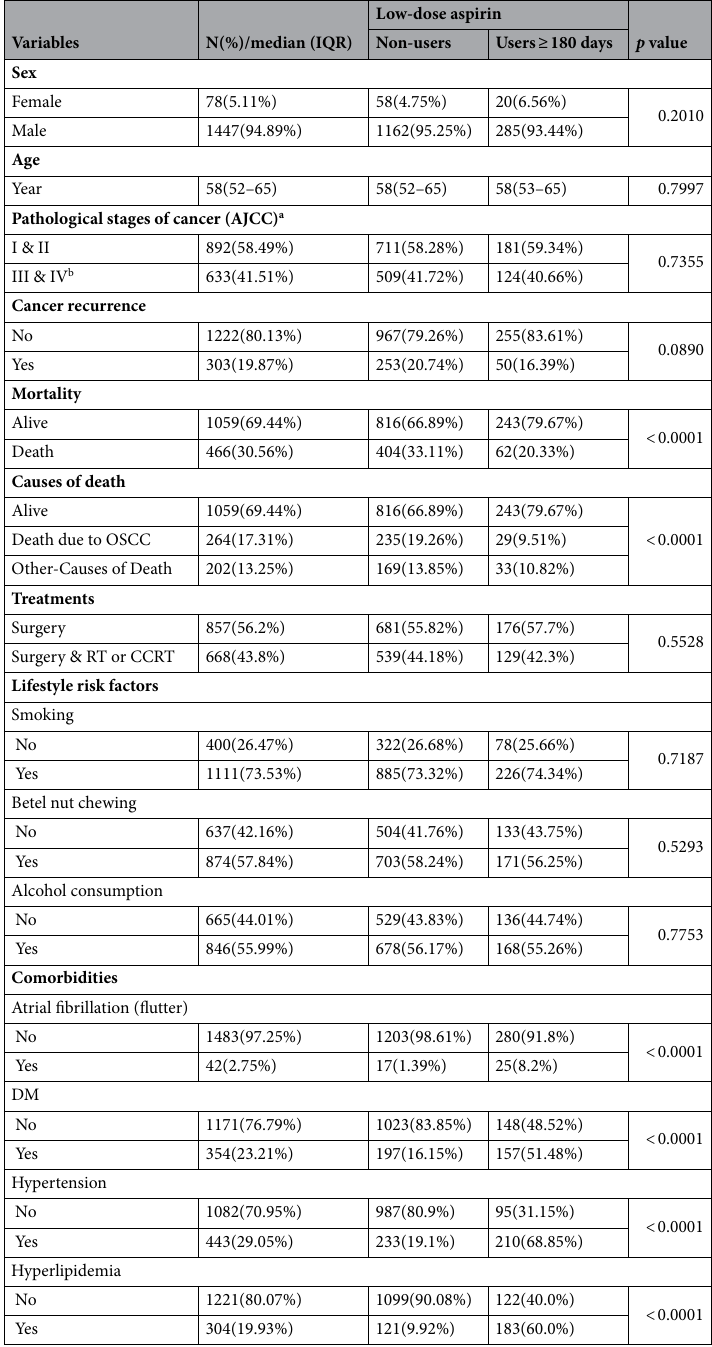
Table 1. Demographic and clinical characteristics of the cohort study (n = 1525). IQR Interquartile range, RT Radiotherapy, CCRT Concurrent chemoradiotherapy, DM Diabetes mellitus. a Pathological AJCC Cancer Staging 7th Edition. b Stages IVa and IVb